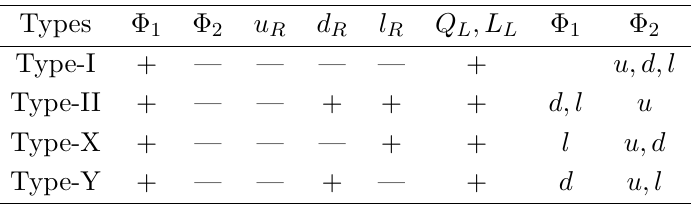
Table 3. Four types of assignments for the Z 2 charges of the Φ 1 , 2 and SM fermions. The last two columns indicate the non-zero Yukawa coupling of each scalar doublets Φ 1 , 2